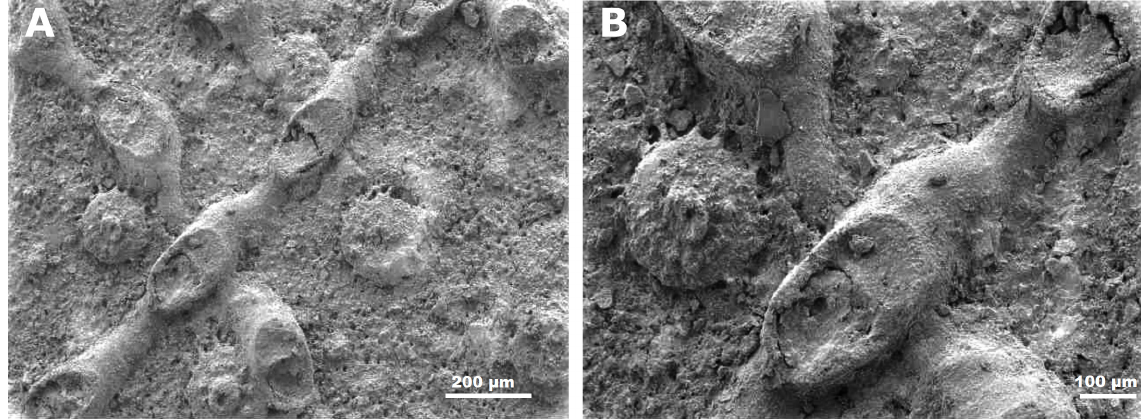
Fig. 7. Crepis gurjarensis Guha & Gopikrishna, 2005 (GIS/B 0504). A . General view of the colony encrusting an echinoid test showing uniserial chains with branching on both sides. B . Close-up of an autozooid showing oval opesia, cryptocyst and well-developed